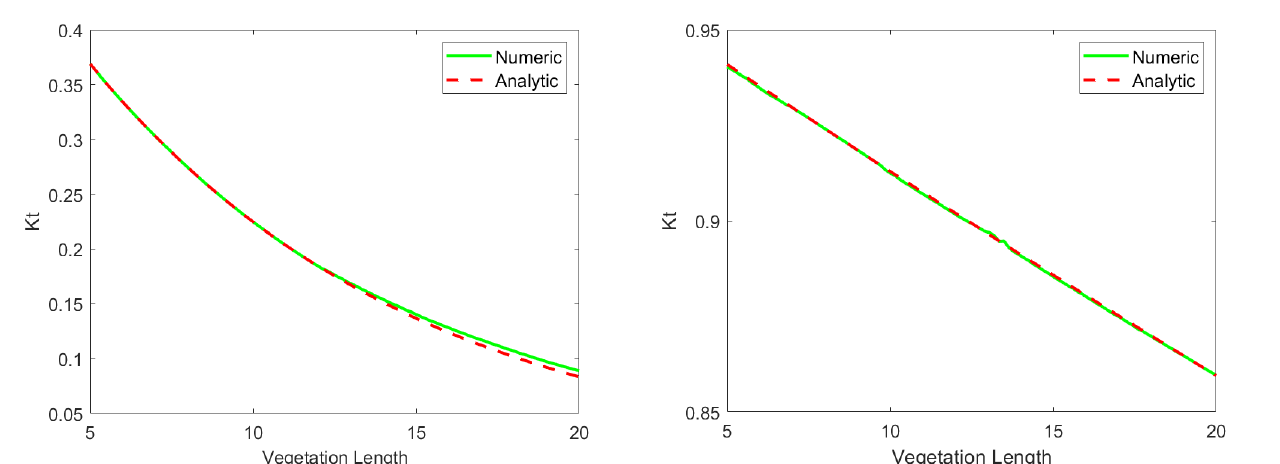
Figure 7. Numerical and Analytical Comparison of Transmission Coefficient K t and Vegetation Length Relation with ( left ) Friction Coefficient, c f = 0.32 ( right ) Diffusion Coefficient, c D = 0.3.